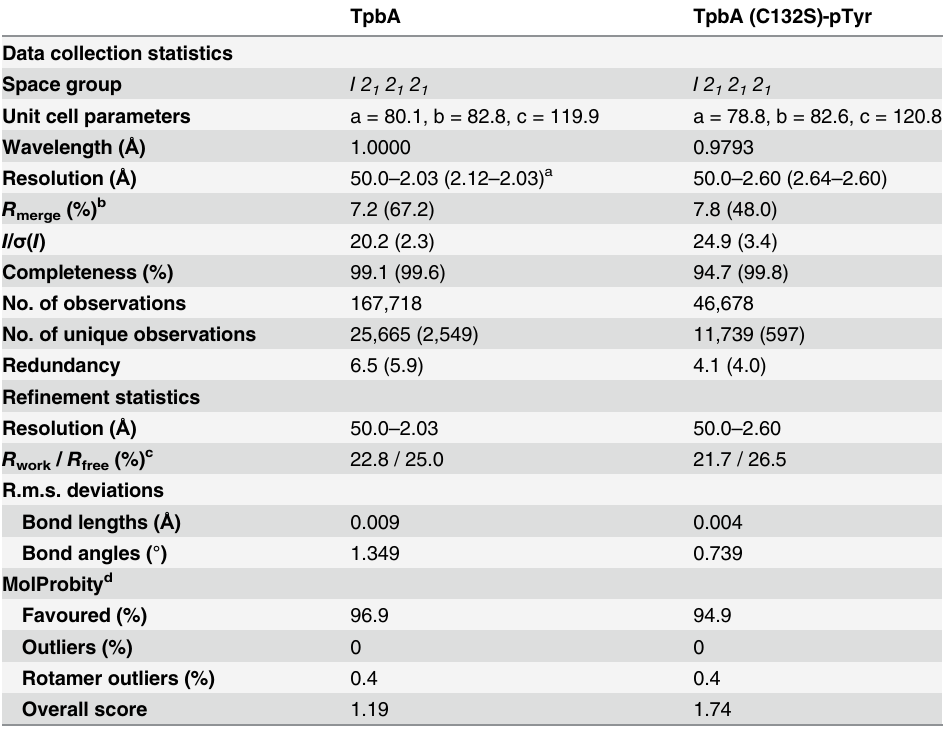
Table 1. Data collection and refinement